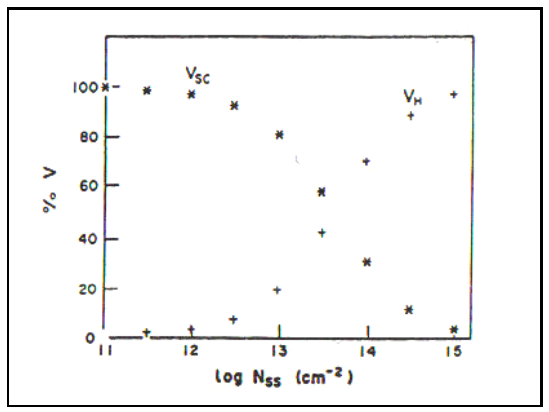
Figure 6. Relative potential drop in the space charge region and in the Helmholtz region as a function of surface state density (Reprint from [29] and [32]).